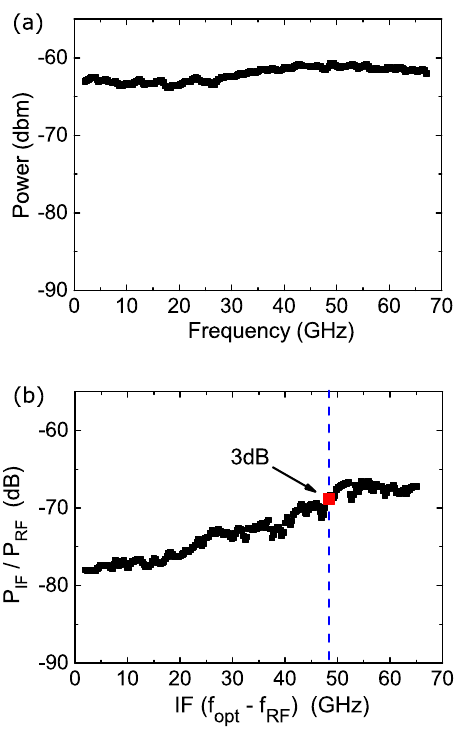
Fig. 4 RF Optoelectronic characterization. a Maximum photodetected power at V GS = 0V, V DS = 330 mV, as a function of f opt . b P IF / P RF at V GS = 0.6V, V DS = 330 mV. Optical power in a , b is 60